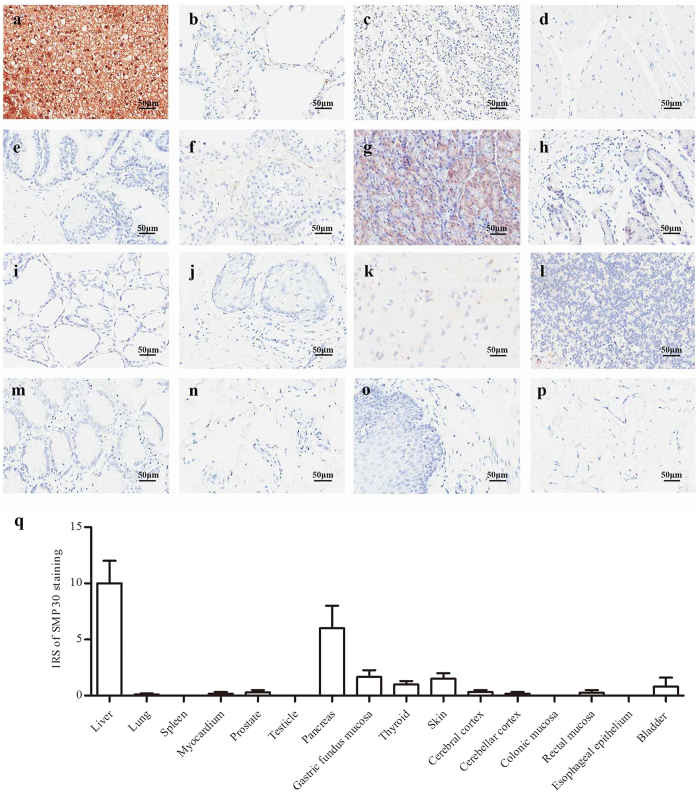
Showing that SMP30 expression is high in normal liver tissue.Immunohistochemical representative images of SMP30 expression in (a) Liver. (b) Lung. (c) Spleen. (d) Myocardium. (e) Prostate. (f) Testicle. (g) Pancreas. (h) Gastric fundus mucosa. (i) Thyroid. (j) Skin. (k) Cerebral cortex. (l) Cerebellar cortex. (m) Colonic mucosa. (n) Rectal mucosa. (o) Esophageal epithelium. (p) Bladder epithelium. The original magnification of IHC staining is 200 × . (q) Immunoreactivity score (IRS) of SMP30 staining was available from 16 human normal tissues and organs. The data represent the mean ± SD. P < 0.05.